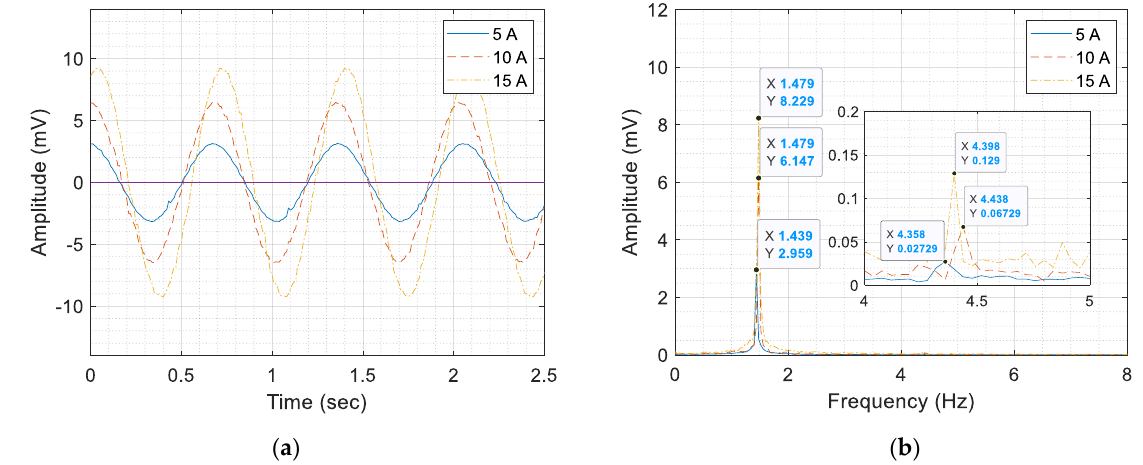
Figure 14. This figure shows the speed of the rotating coil at 90 rpm (1.5 Hz): ( a ) the electromotive force of the magnetic field at 90 rpm; ( b ) the spectrum of the electromotive force of the magnetic field.